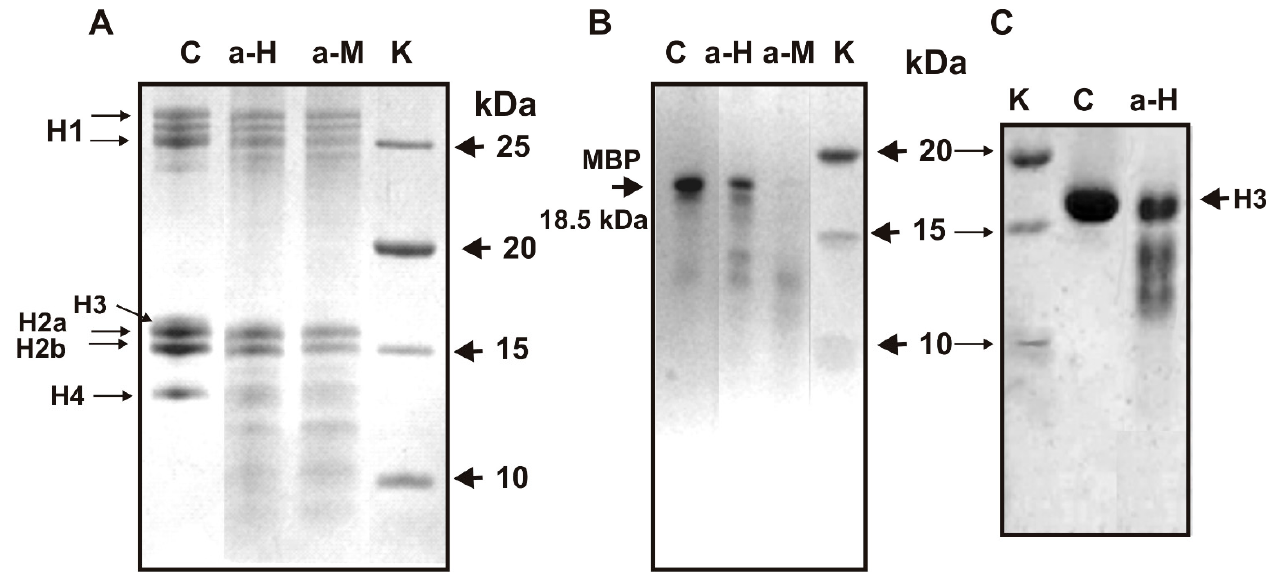
Figure 1. SDS-PAGE analysis of five H1-H4 histones hydrolysis by IgGs against five histones (lane a-H) and MBP (lane a-M) ( A ) as well as MBP by anti-histones (lane a-H) and anti-MBP IgGs (lane a-M) ( B ). Hydrolysis of homogeneous H3 histone by IgGs against five histones ( C ). Lane C correspond to hive histones ( A ), and MBP ( B ) and homogeneous H3 ( C ) incubated in the absence of IgGs. Lane K corresponded to proteins with known molecular masses ( A – C ). Five histones, MBP and homogeneous H3 in the absence and in the presence of IgGs (0.03 mg/mL) were incubated for 10